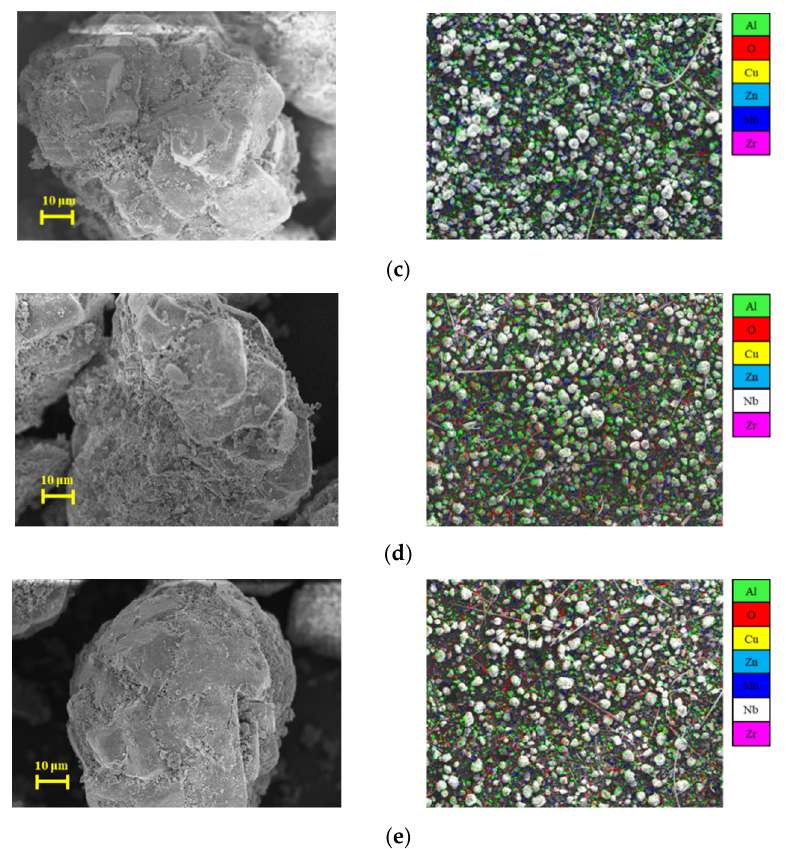
Figure 2. FESEM images and EDX mapping of catalysts for ( a ) fresh ( b ) 5 h ( c ) 2 days ( d ) 7 days and ( e ) 14 days. Table 3. Elemental compositions of samples using EDX analyses on carbon tape.